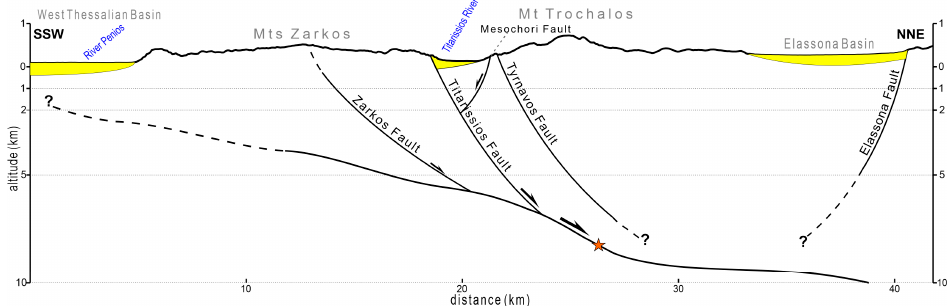
Figure 17. Schematic profile showing the proposed tectonic model for the first mainshock (3 March, orange star indicates the hypocentre). Modified after Chatzipetros et al. [60] and Pavlides & Sbo- ras